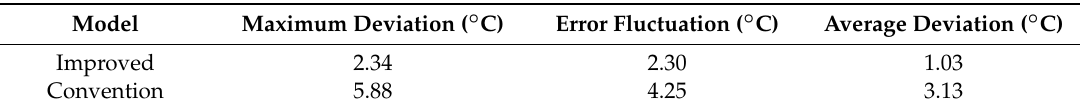
Figure 15. Comparison of the junction temperature estimated by two models: ( a ) T j ( t ); ( b ) errors with respect to the IR camera. Table 5. Comparison of the two models with respect to the IR camera.